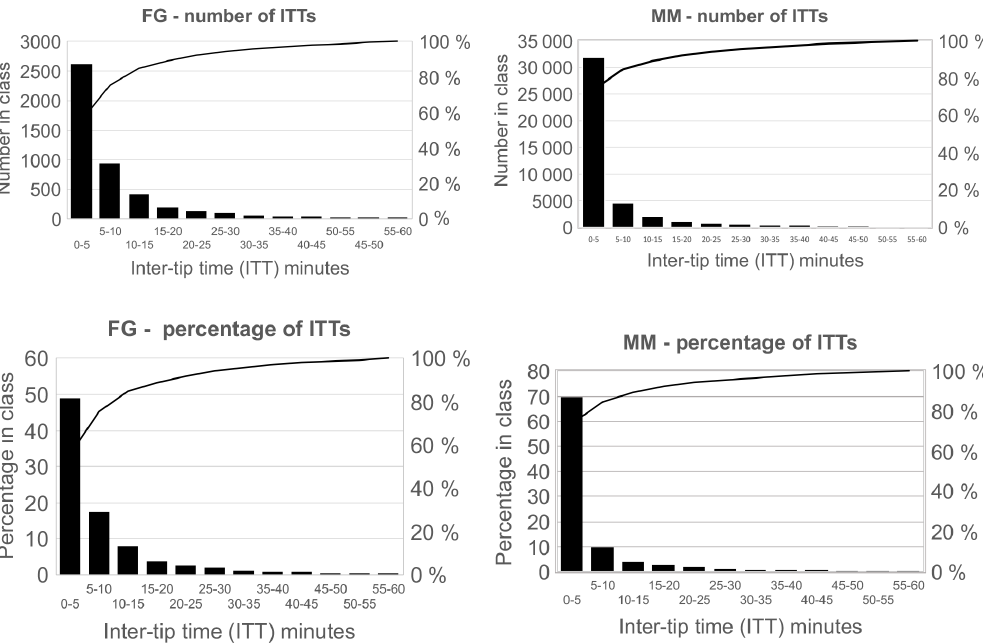
Figure 2. Distributions of the number of inter-tip times (ITTs) in the rainfall records from the Fowlers Gap (FG) and Millaa Millaa (MM) field sites, in 5min bins, for all ITTs up to 1h. Also shown is the percentage of ITTs falling into each ITT class.